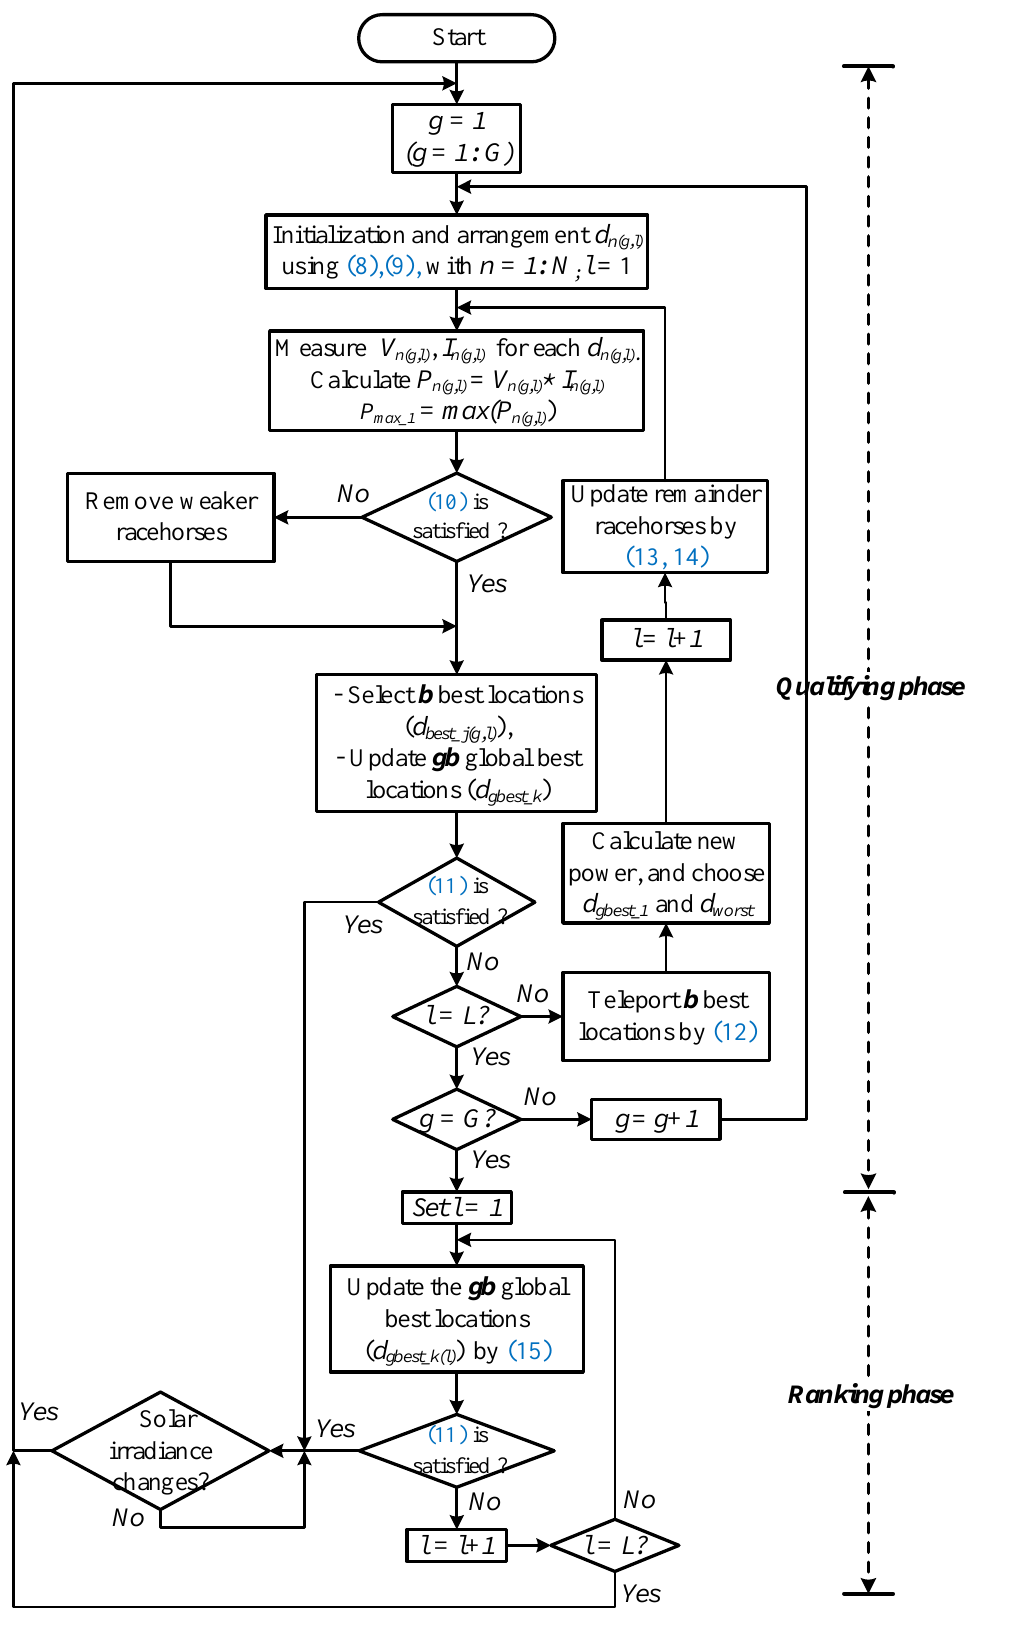
Figure 5. Flowchart of the proposed HRA MPPT method. With initial location arrangement in the qualifying stage, the proposed MPPT method will avoid falling into the local MPP trap and quickly find the global MPP. The proposed method is resulting in the faster response because only the qualified racehorses